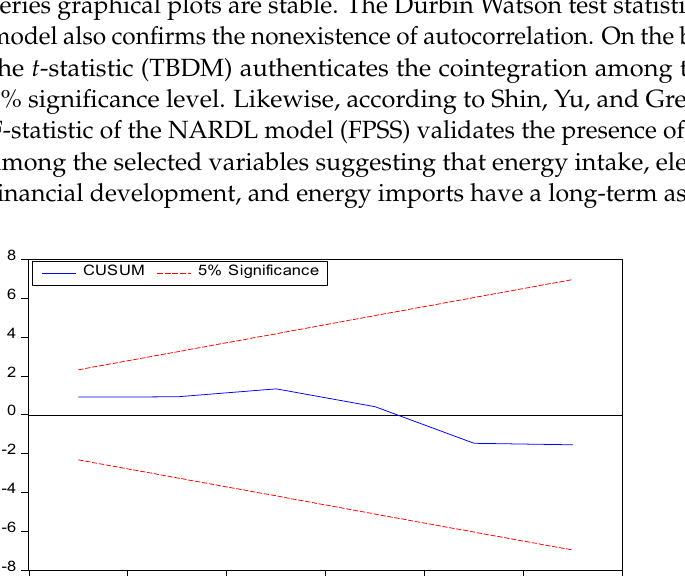
Table 5. Non-linearity test.